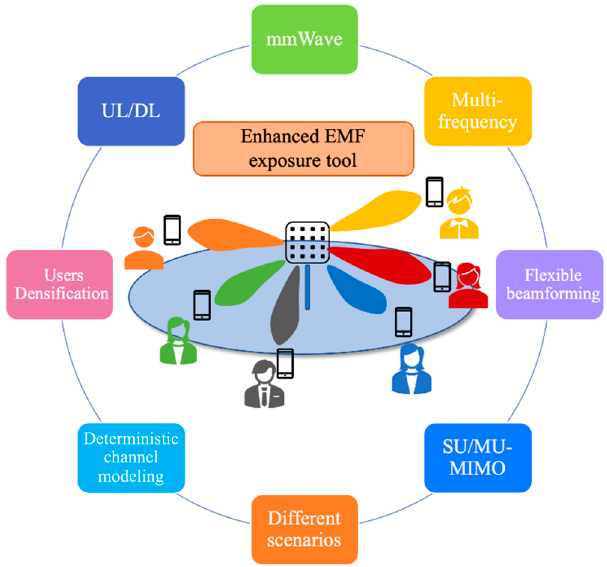
Figure 1. Schematic view of the distinctive characteristics of the enhanced EMF exposure simulation tool.